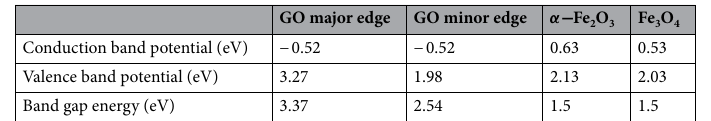
Table 1. Band edge positions of Graphene oxide, Fe 3 O 4 and α-Fe 2 O 3